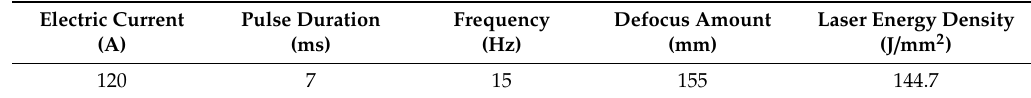
Figure 3. Biomimetic unit model. ( a ) The stripe biomimetic cell model; ( b ) the mesh biomimetic cell model.